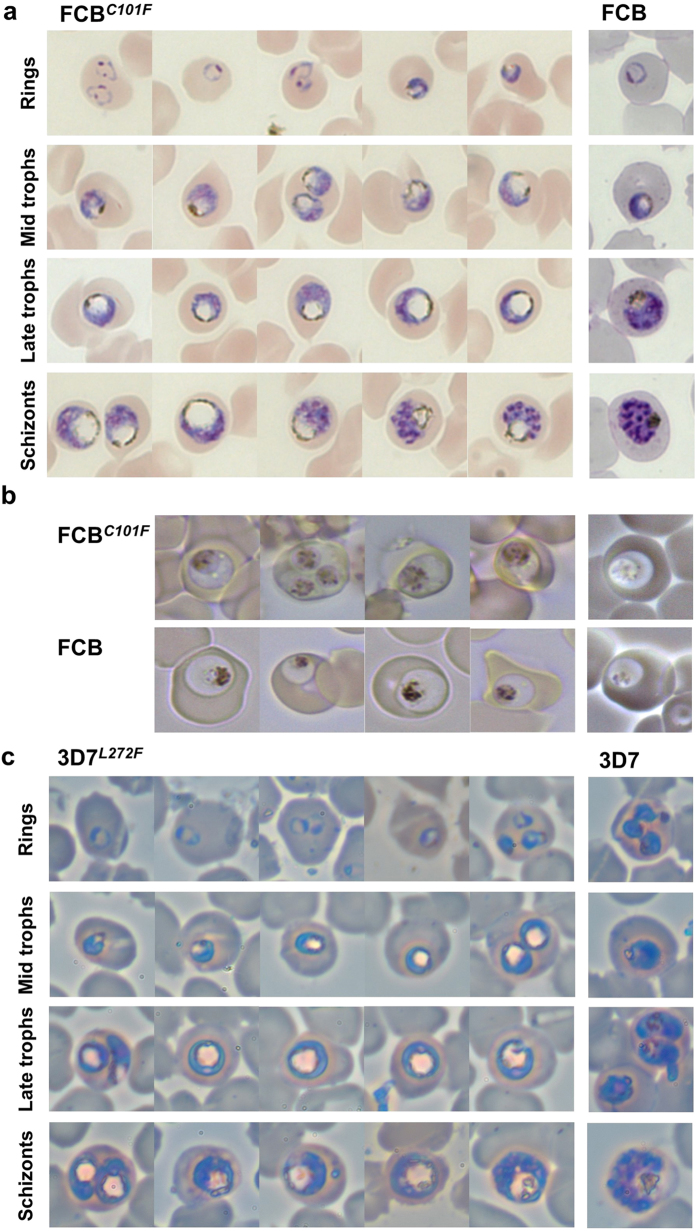
Representative morphology of parasite lines FCBC101F and 3D7L272F.(a) Appearance of enlarged FVs in fixed FCBC101F parasites (left panel), when compared with parental FCB parasites of similar developmental stages (right panel). (b) Images of live FCBC101F and FCB trophozoite-stage parasites, using bright-field and dark-field microscopy (left and right panels, respectively). (c) Appearance of enlarged FVs in fixed 3D7L272F parasites (left panel), when compared with parental 3D7 parasites of similar developmental stages (right panel). The diameter of a RBC is ~7 μm.